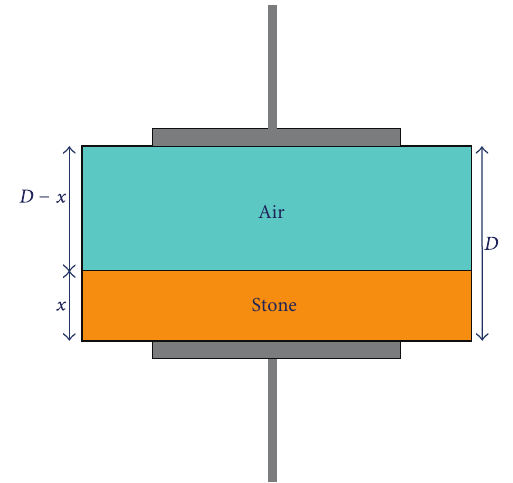
F 19: Multidielectric layer (air/stone) capacitive